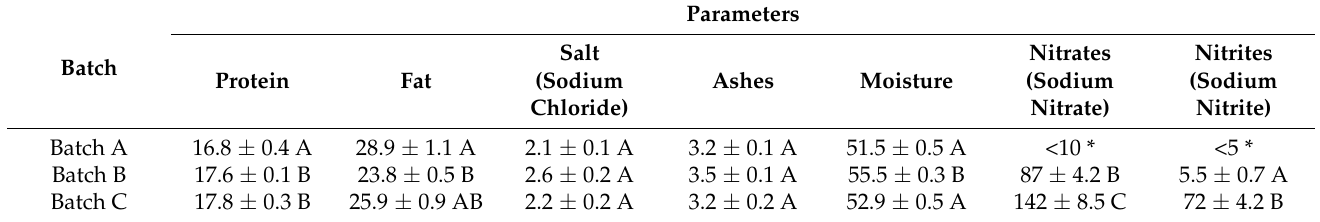
Table 1. Proximal composition and nitrate/nitrite content analyzed in the batter used to produce the Milano-type salami. Each parameter is expressed as g/100 g (proximal composition) or mg/kg (nitrates/nitrites). Values are the means ± standard deviation of two replicates samples for Batch A (basic recipe), Batch B (vegetable nitrates), and Batch C (synthetic nitrates/nitrites). For each parameter, means with different uppercase letters within a column are significantly different ( p < 0.05) among